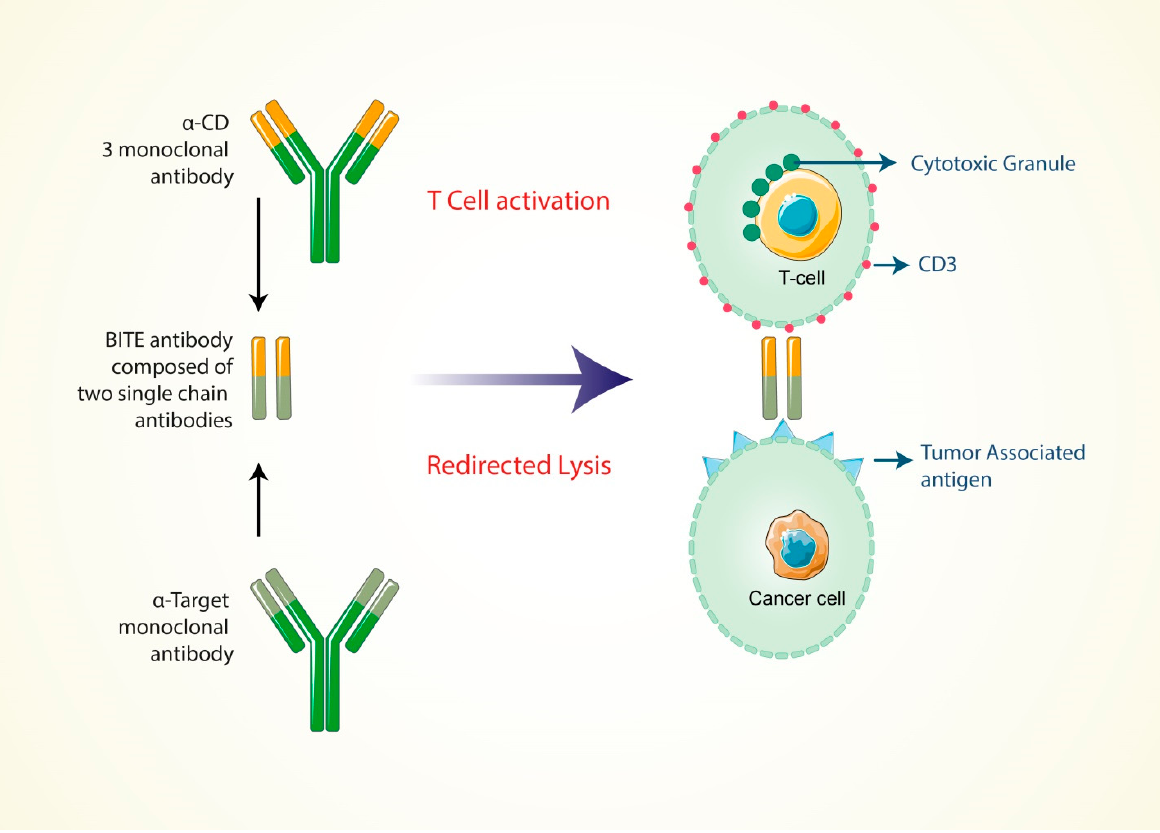
Figure 2. Formation of bi-specific T-cell engaging antibodies for cancer therapy. Bi-specific antibodies are specific for the CD3 and CD19 marker of cancer